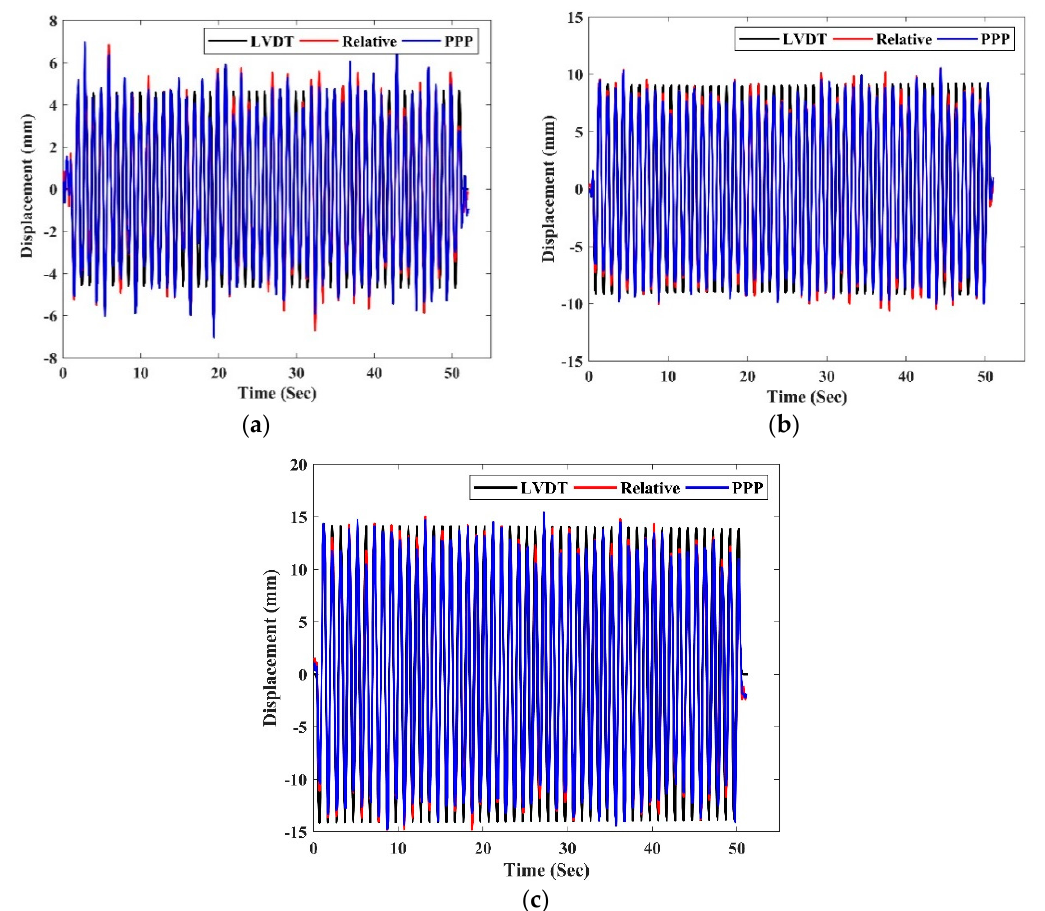
Figure 11. Dynamic movements of seismic movement of events: ( a ) event 2, ( b ) event 3, and ( c ) event 4.